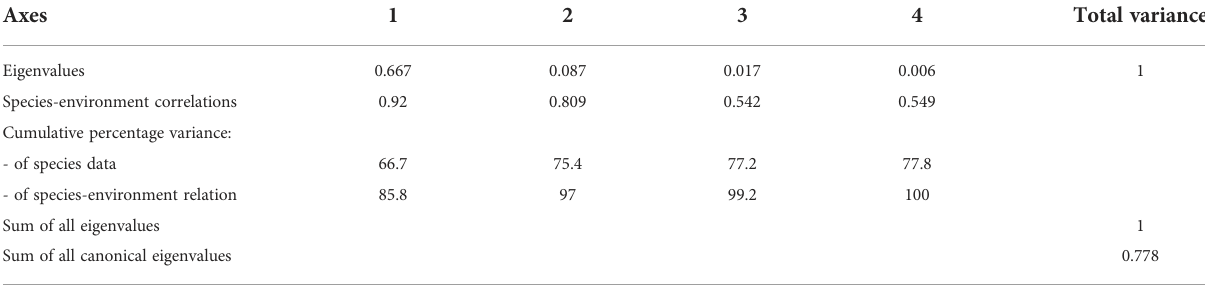
TABLE 2 Summary of the results of the redundancy analysis (RDA) between environmental variables and dominant species in the inner bay. Axes 1